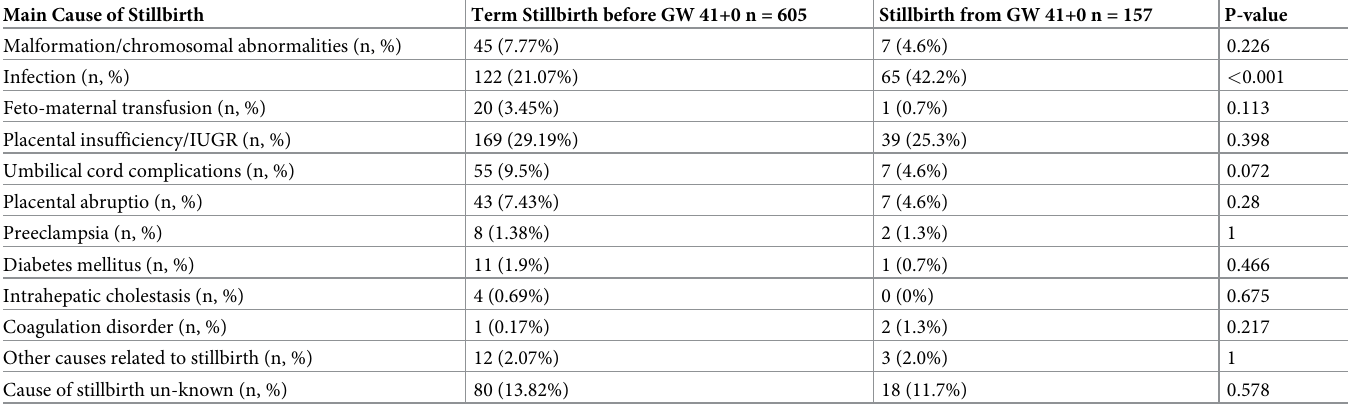
Table 3. Main cause of stillbirth according to the Stockholm Stillbirth Classification comparing term stillbirths at GW 37+0 -40+6 with term stillbirths at GW 41+0 and onwards. Main Cause of